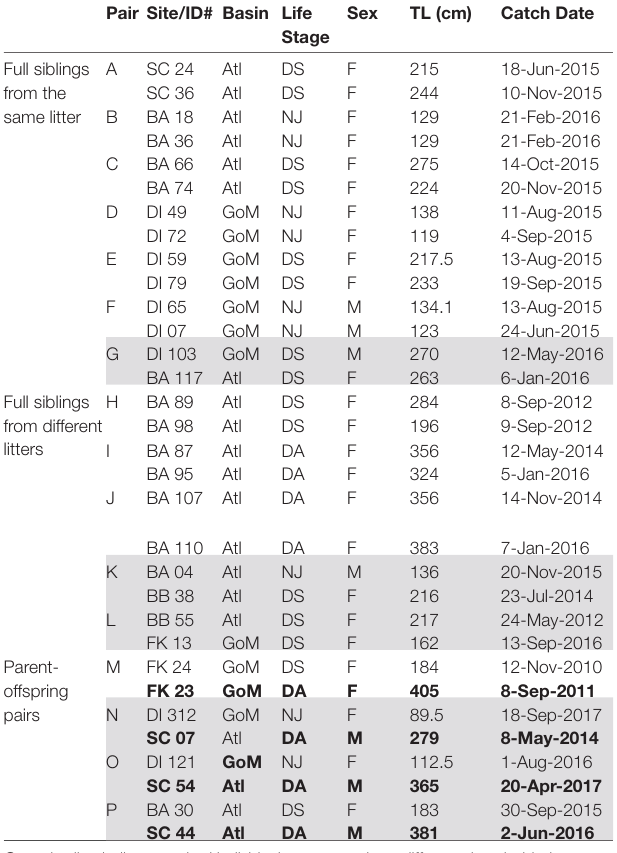
Grey shading indicates paired individuals were caught at different sites; bolded individuals were identified as likely adults (>300 cm TL), i.e. potential genetic